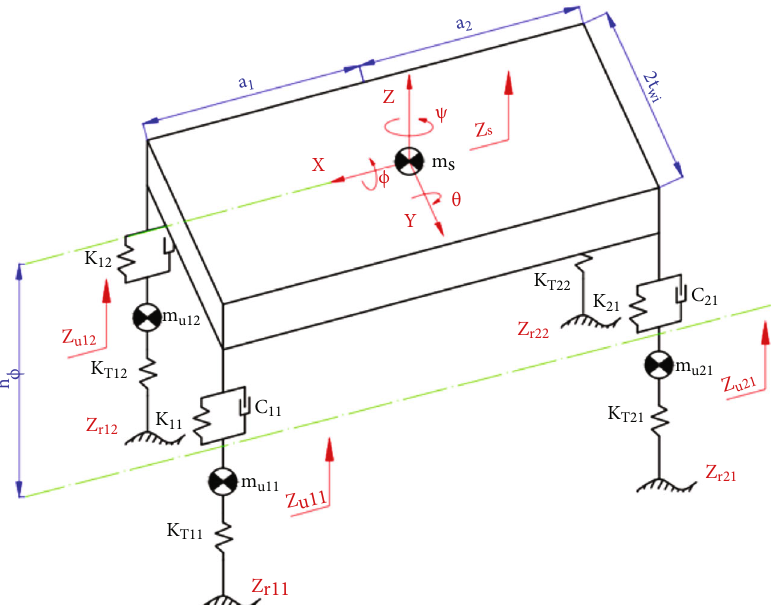
Figure 1: A model of the